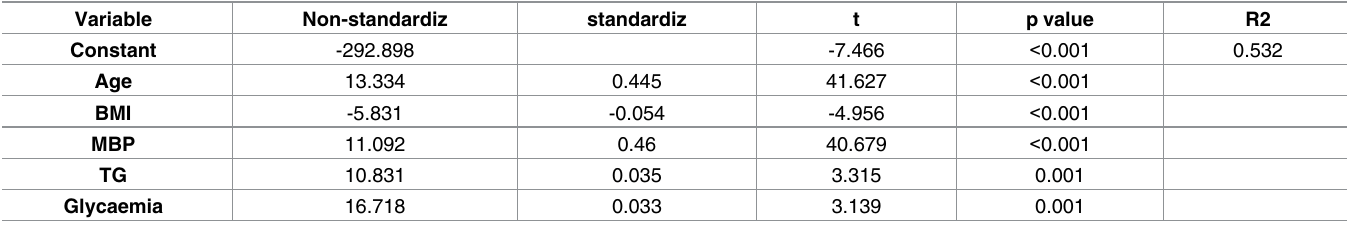
Table 3. Multiple regression analysis using baPWV as dependent variable.